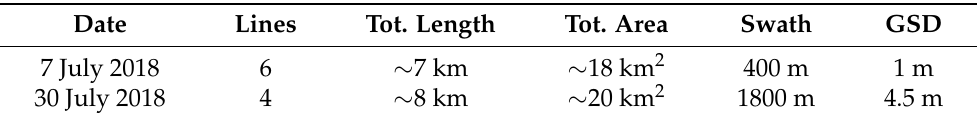
Table 2. Technical features of HyPlant-DUAL acquisitions over the study area, during the 2018 ESA FLEXSENSE campaign held in Grosseto. Tot.